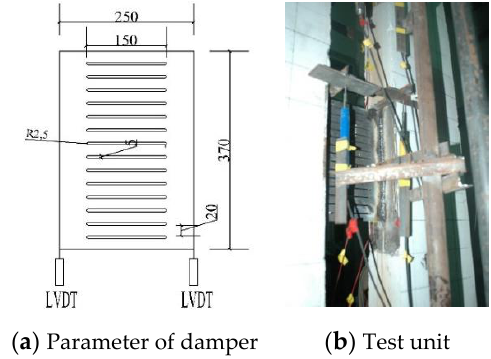
Figure 2. Diagram of damper.